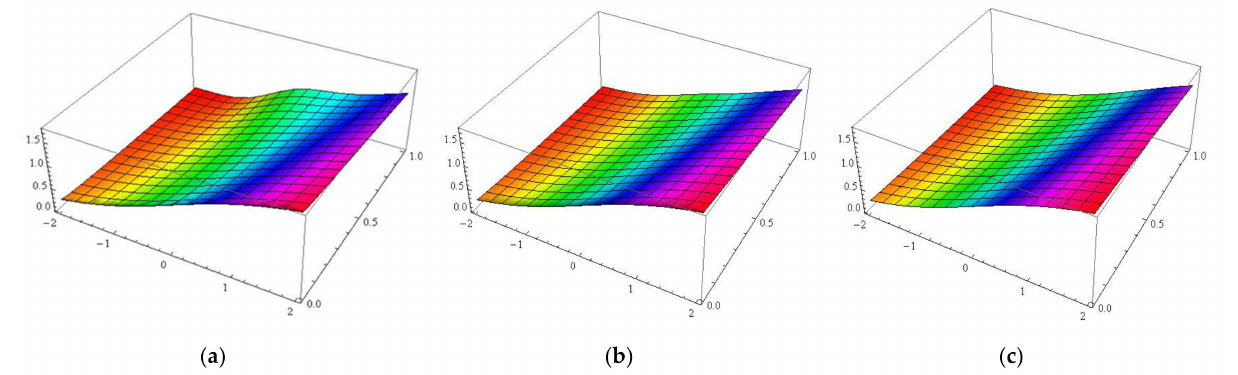
Figure 1. The surface graph of the 3D plots of the 5th-approximate L-RPS solution u 5 ( x , t ) in Equations (23) and (24) at: ( a ) β = 0.6 ( b ) β = 0.75 ( c ) β =